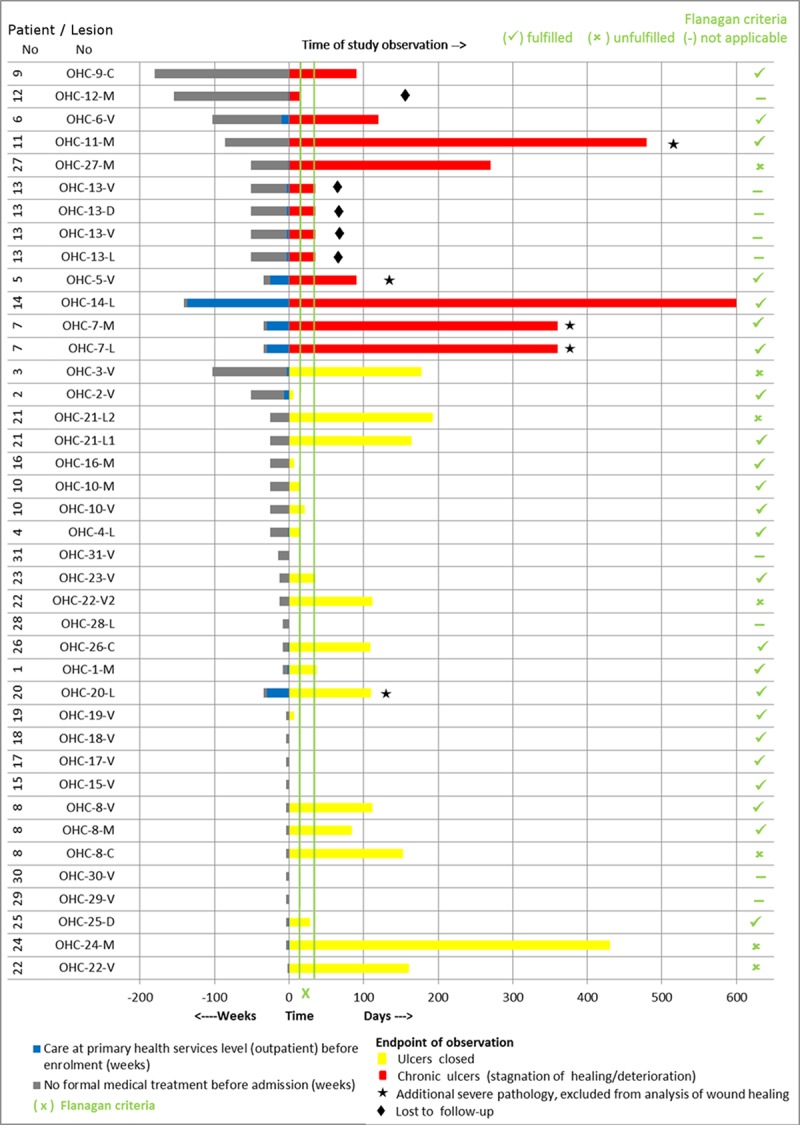
Pre-enrolment history and post-enrolment observation of IS2404 PCR positive ulcers of the study patients at the PHC center (the patient code “OHC” refers to the patient numbering at the PHC center in Obom).